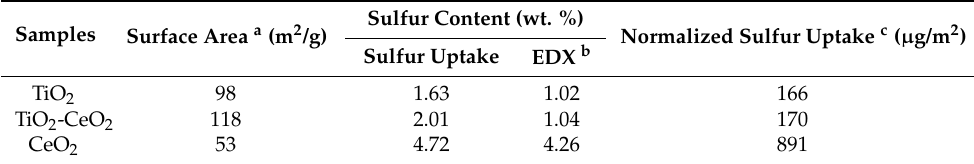
Table 1. Sulfur accumulation and normalized sulfur uptake of the TiO 2 , TiO 2 -CeO 2 and CeO 2